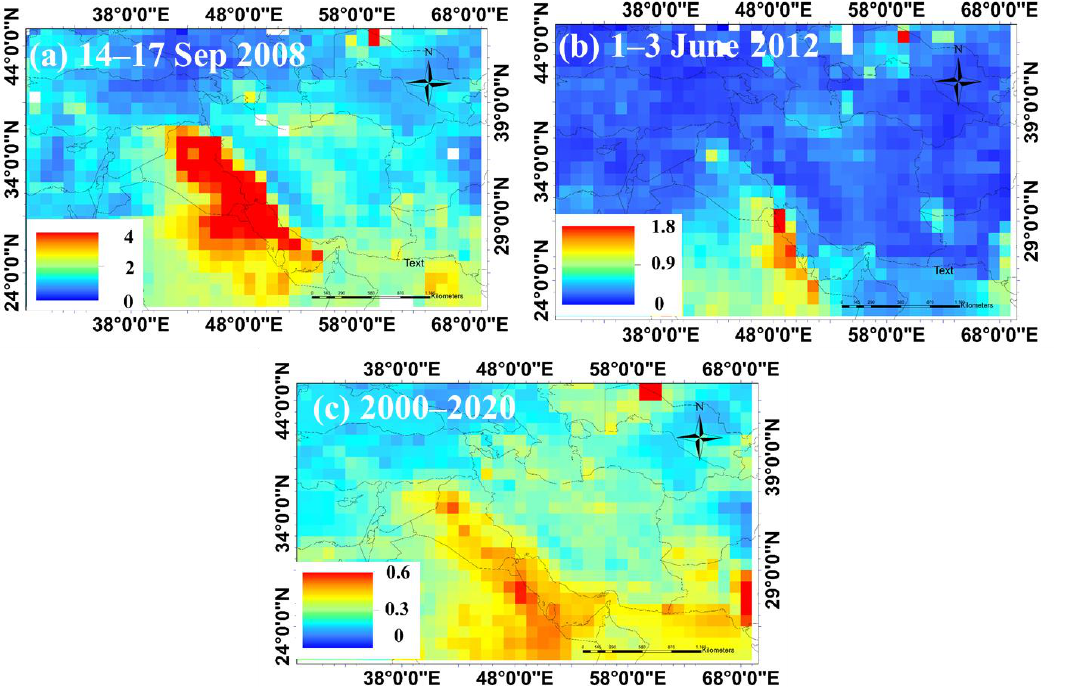
Figure 9. Mean AOD550 spatial distribution from Terra-MODIS observations during the periods ( a ) 14 – 17 September 2008, ( b ) 1 – 3 June 2012, ( c ) 2000 – 2020. True-color imagery from Aqua/MODIS was used in the two dust storm events over the Middle East area; CALIPSO overpasses over the region are shown with yellow arrows (first column). In Figure 10, an intense dust plume was detected over northern Iraq and western Iran in the first case while the dust plume was detected over southern Iraq, Ku- wait, the Persian Gulf, and northern Saudi Arabia in the second case. According to the CALIPSO profiles, this dust plume rose higher in the first case and dust particles rose higher than 7 km over Mesopotamia toward the eastern Arabian Peninsula; the height of the dust plume did not decrease on 15 September 2008. On 2 June 2012, the dust plumes did not ascend as the first case but rose higher than 5 km in a vast area over the Persian Gulf and south of Iran. It seems that the NAAPS model`s vertical profile output agrees with the CALIPSO vertical profile over the Persian Gulf in this case, and dust rose higher than 5 km (500 hPa). This result is not off; the dust rising occurred at different levels of the atmosphere, and many dust particles reached 5 km (or even 6 km) in height [78 – 80].